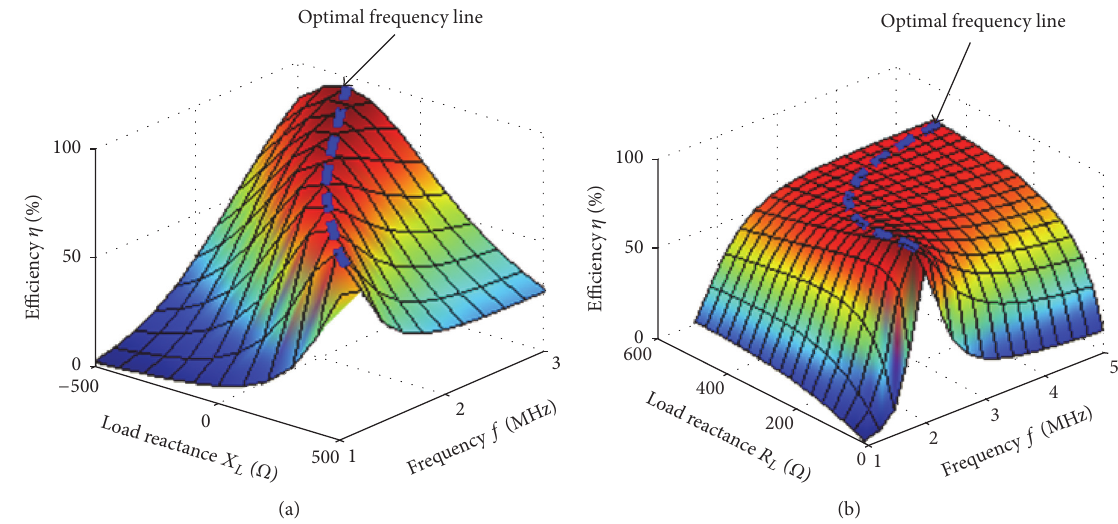
Figure 4: (a) Calculated 𝜂 total versus 𝑋 𝐿 and 𝑓 . (b) Calculated 𝜂 total versus 𝑅 𝐿 and 𝑓 .